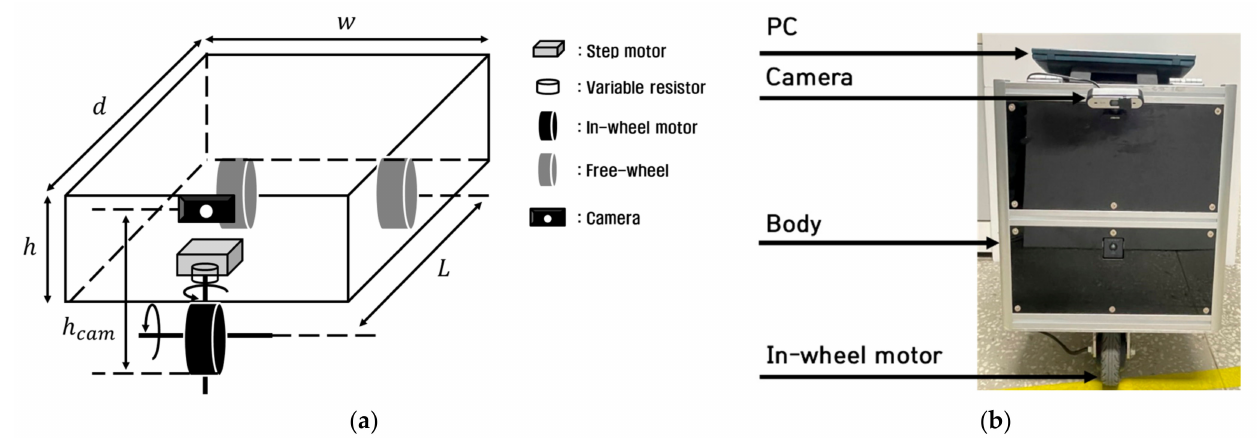
Figure 7. ( a ) Concept of the developed autonomous truck; ( b ) image of the developed actual autonomous truck.